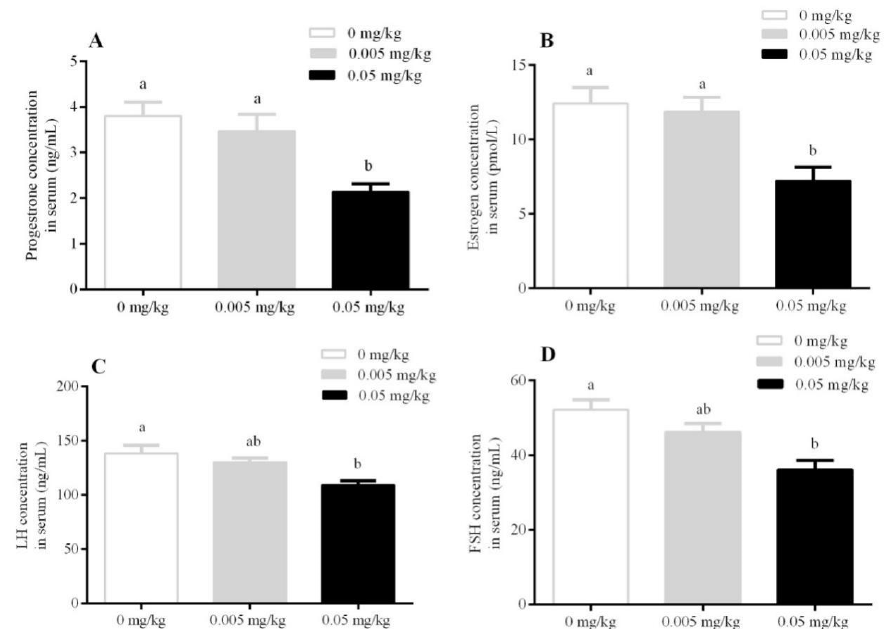
Figure 2. Effect of T-2 toxin exposure on the serum hormone concentration of female mice whose dams were orally administered with T-2 toxin at 0, 0.005, and 0.05 mg/kg from gestational day 14 (GD 14) to lactational day 21 (LD 21). ( A ) progesterone, ( B ) estrogen, ( C ) luteinizing hormone, ( D ) follicle-stimulating hormone. Each value represents the mean ± SEM of the group ( n = 5). Different letters indicate statistically significant differences, p < 0.05.